Question: What kind of plot is shown here?
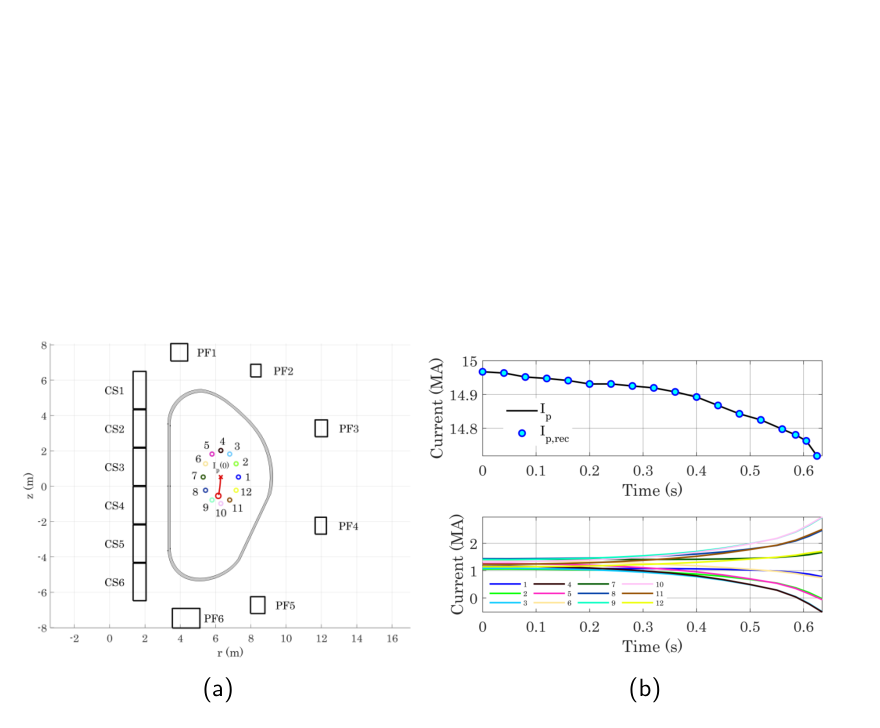
Answer: line